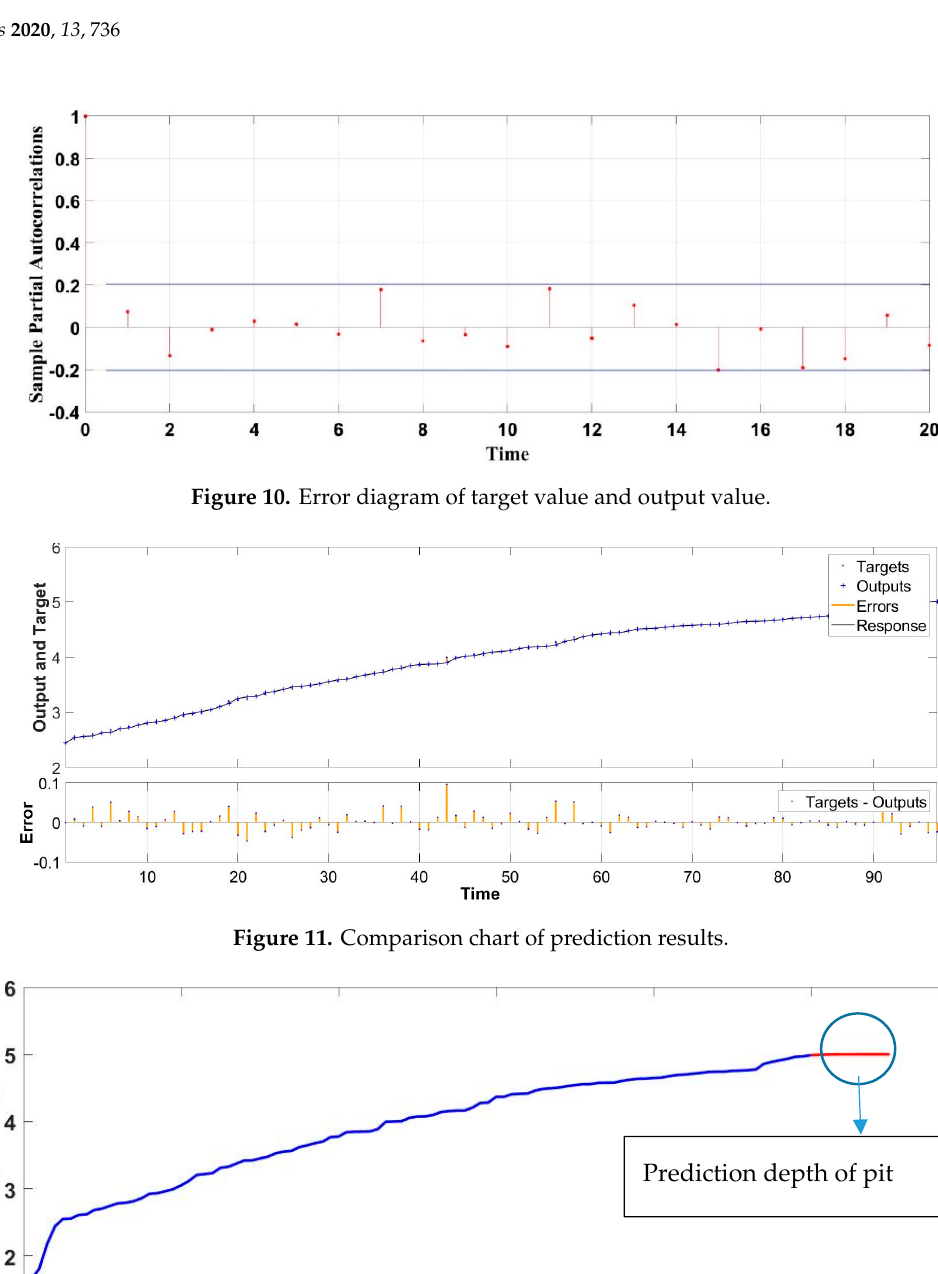
Prediction depth of pit